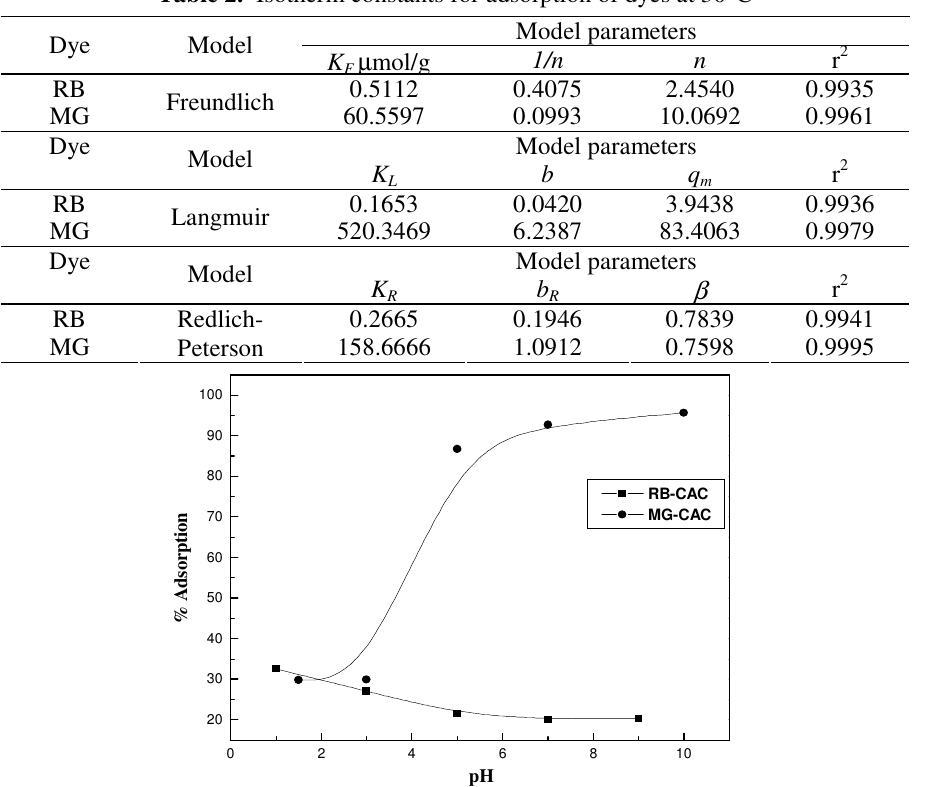
Figure 2. Effect of pH on the adsorption of RB and